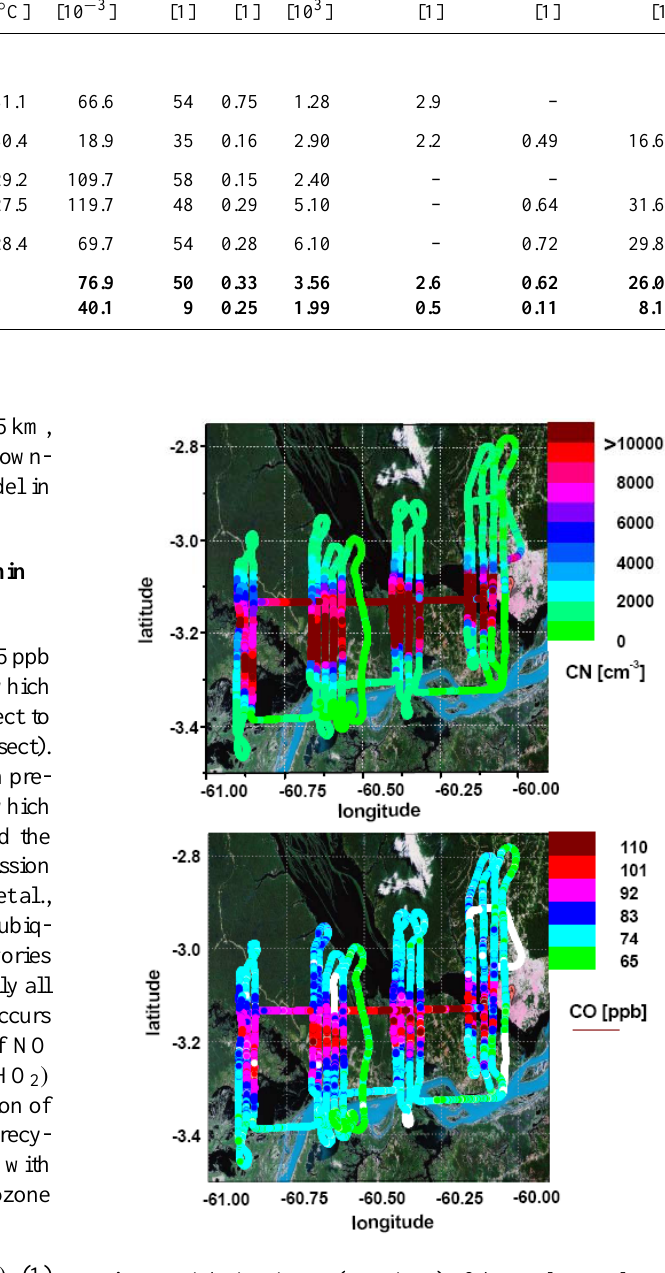
Fig. 5. Bird view image (see Fig. 1) of the total aerosol number concentration (CN) and CO mixing ratios observed downwind of Manaus City ( − 3.08 ◦ , − 60.01 ◦ ) during Flight #18 on 19 July 2001, 10:00–14:00LT As flight legs at a certain distance of Manaus lie on top of each other (compare Figs. 1, 2), perspective is added in a way that highest altitudes transects are displayed on most right-hand side. One longitudinal degree corresponds to ∼